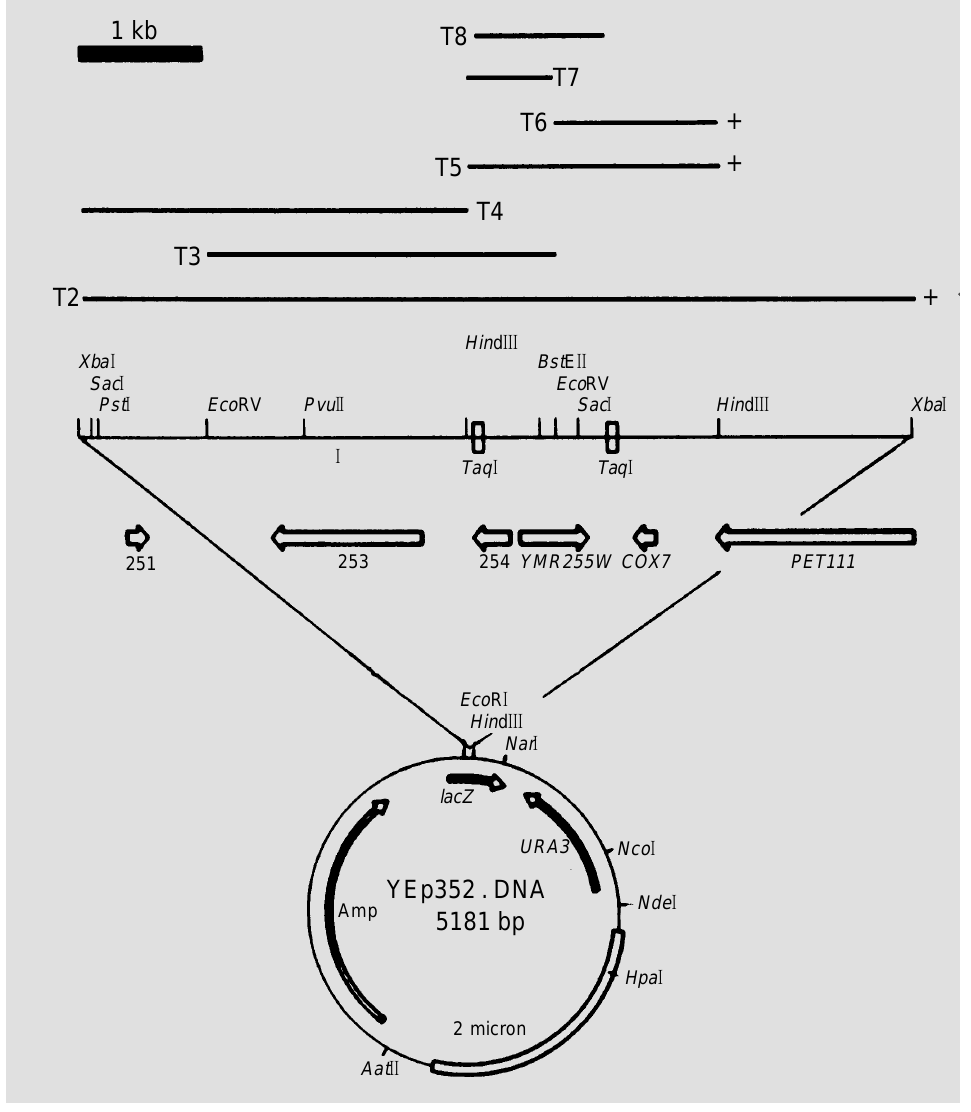
Figure 1 - Partial restriction maps of pG199/T2 and derivative plas- mids. The larger insert (T2) is a 6.9-kb fragment of nuclear DNA ligated at the Xba I site of vector YEp352. The locations in YEp352 of the URA3 and the ß- lactamase genes are shown. The bars in the upper part of the figure represent the size and po- sition of the indicated subclones relative to the larger (T2) insert. The arrows below the restriction map represent the main ORFs present in this segment of chro- mosome XIII. The two Taq I sites that define subclone T8 are indi- cated. The plus signs denote the recombinant plasmids that complement the respiratory de- ficiency of group G199